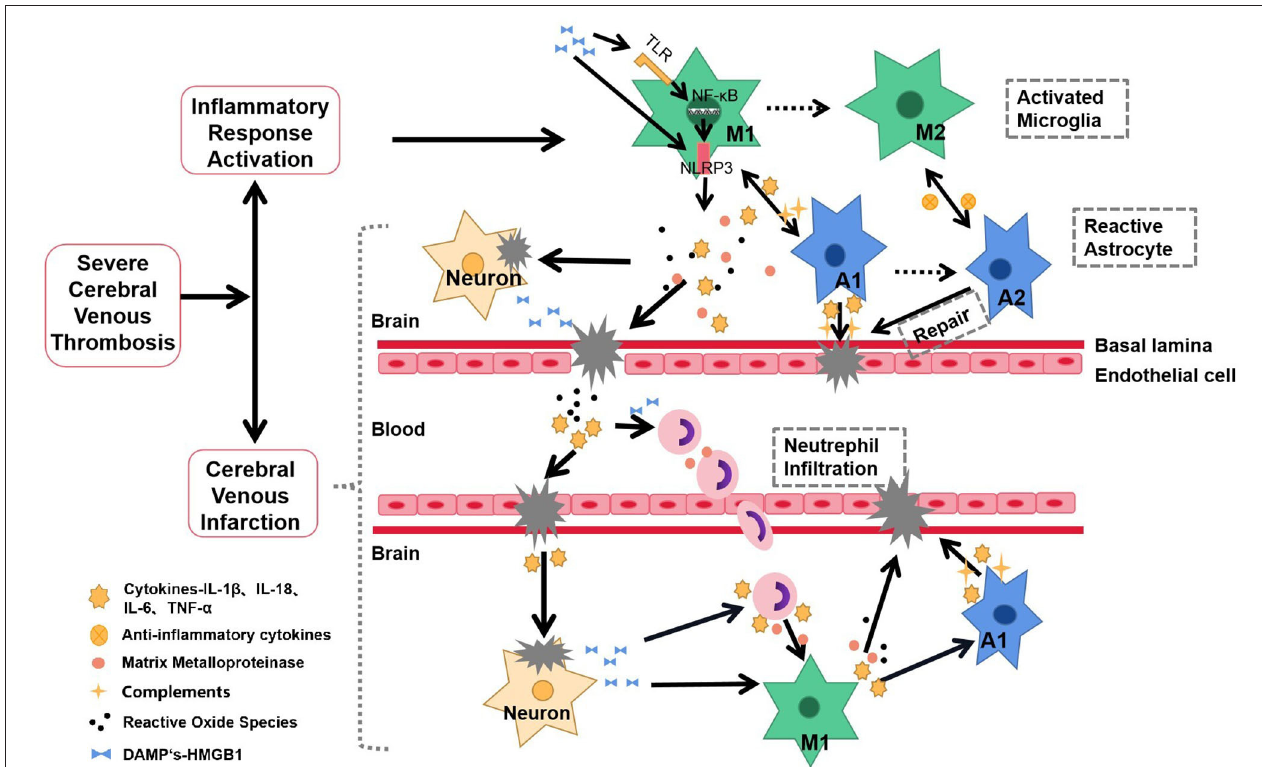
FIGURE 1 | Schematic representation of inflammatory response in the pathophysiology and pathogenesis of severe CVT. After the onset of severe CVT, the inflammatory response is rapidly activated. The specific manifestations are as follows: central microglia and astrocytes are activated, presenting a proinflammatory state; secretion of inflammatory factors, MMPs, ROS, and other mediators lead to nerve injury, BBB destruction, and cerebral venous infarction. These proinflammatory factors also recruit neutrophils from the periphery into CNS, allowing the further release of proinflammatory mediators, which in turn activate additional microglia and astrocytes. Dying neurons release danger-associated molecular patterns (DAMPs), which activate NLRP3 inflammasomes through TLR-NF- κ B signaling, which activates inflammatory cells to amplify the cascade of disease and injury. The inflammatory response forms a positive feedback loop with nerve injury, aggravating the incidence and intensity of cerebral venous infarction. Solid line, Based on studies with the available evidence; Dotted line, hypotheses that require further